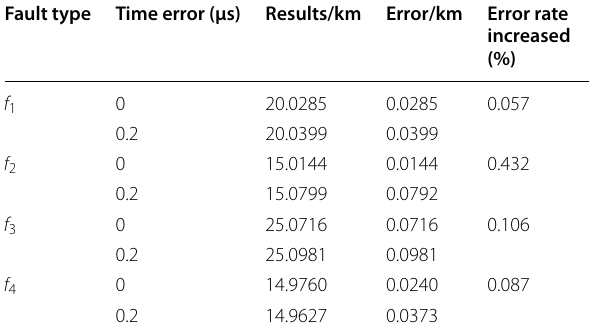
Table 6 Simulation results with time